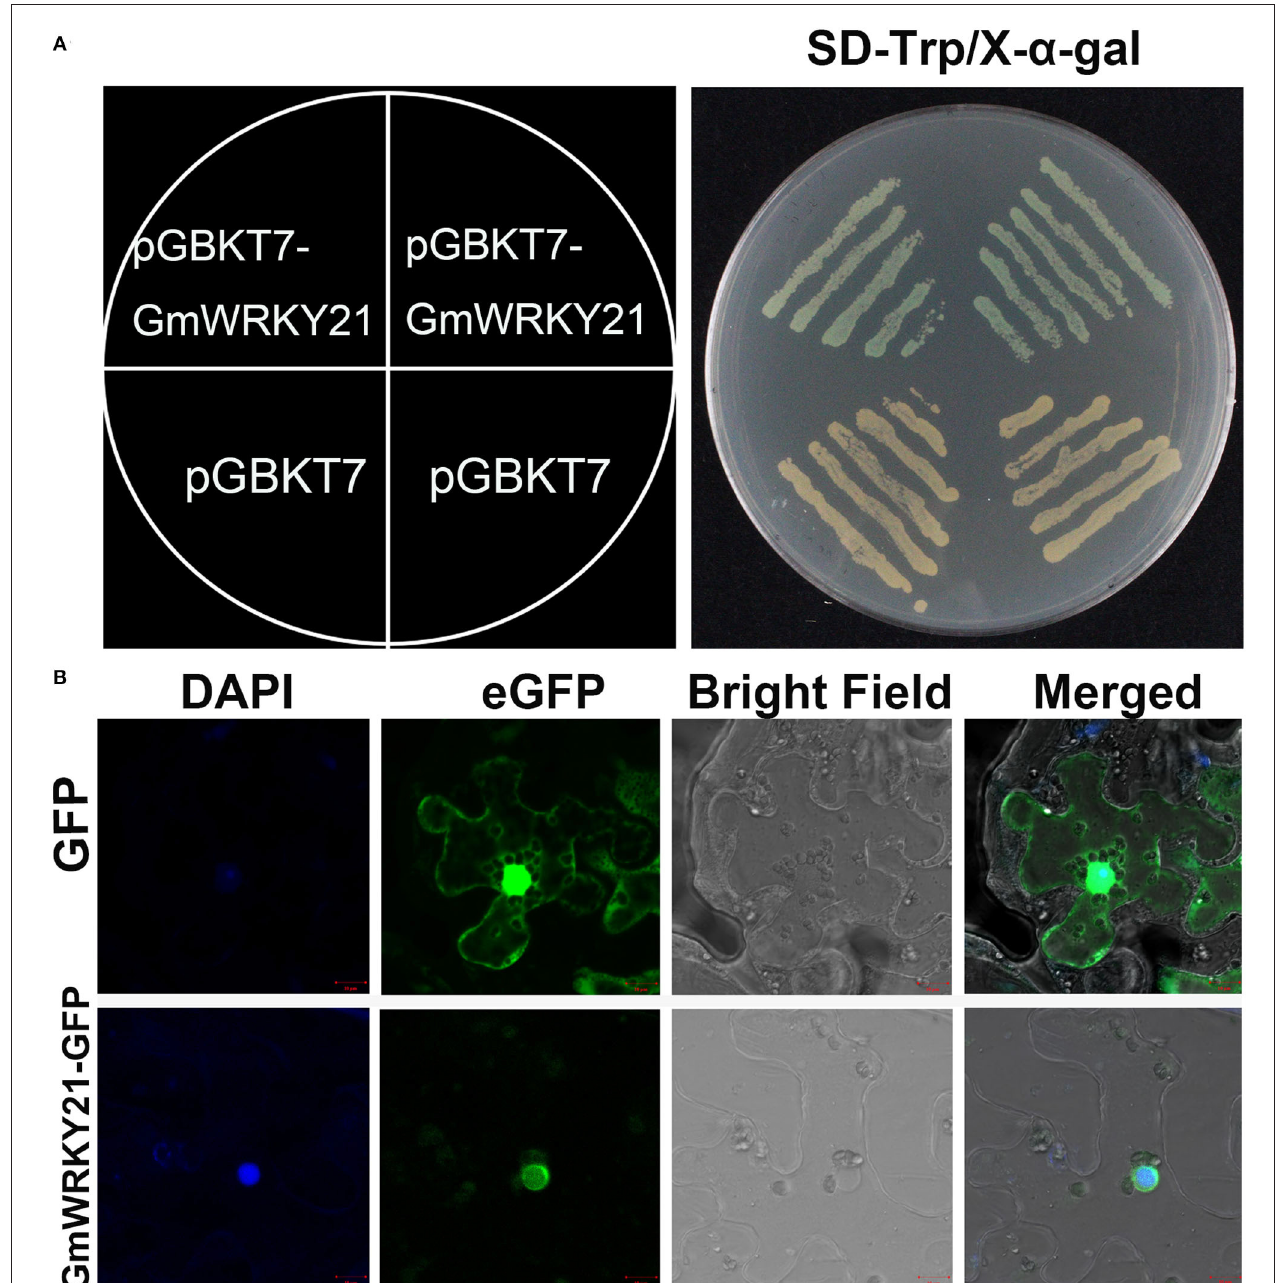
FIGURE 2 | Transcriptional activation and subcellular localization of GmWRKY21 protein. (A) Transcriptional activation analysis of GmWRKY21 protein. (B) Subcellular localization of GmWRKY21 protein in leaf epidermal cells of tobacco. The ORF sequence of GmWRKY21 was inserted into the sites of Eco RI and Bam HI of pGBKT7 vector to form the fusion carrier of GmWRKY21-pGBKT7. The fusion plasmid of GmWRKY21-pGBKT7 and pGBKT7 alone (negative control) were transformed into the cells of yeast strain Y2H. The cell deposits were colored with a chromogenic substrate of X-gal. The full coding sequence of GmWRKY21 (without TGA) was inserted into the Nco I and Spe I sites of pCAMBIA1302 vector to obtain the GmWRKY21-GFP fusion construct. The pCAMBIA1302-GFP vector was transformed as a control. Scale bar (A,B) : 10 µ m.